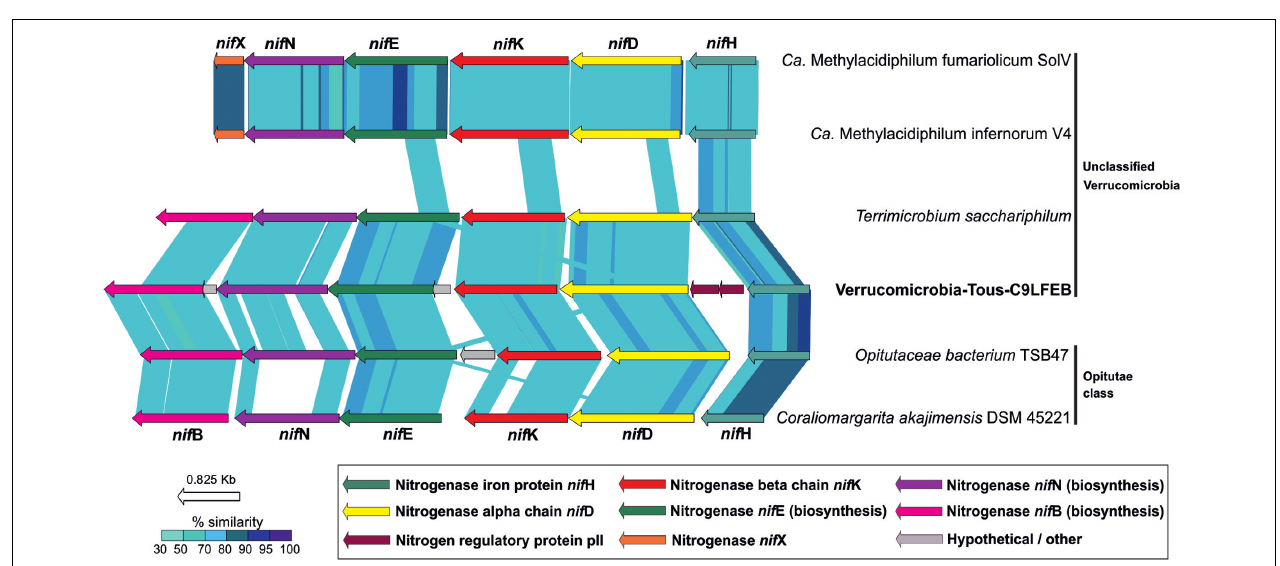
FIGURE 5 | Metabolic overview of Opitutae-Tous-C4FEB genome. All pathways shown are complete in the genome.